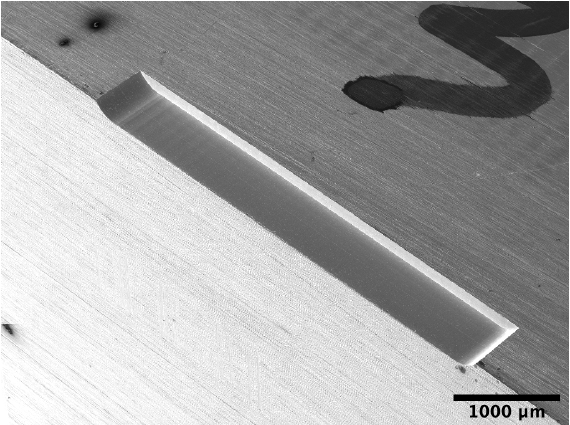
Figure 7. Example of the produced structures. The roughness and indentation measurements have been performed on the horizontal surface.